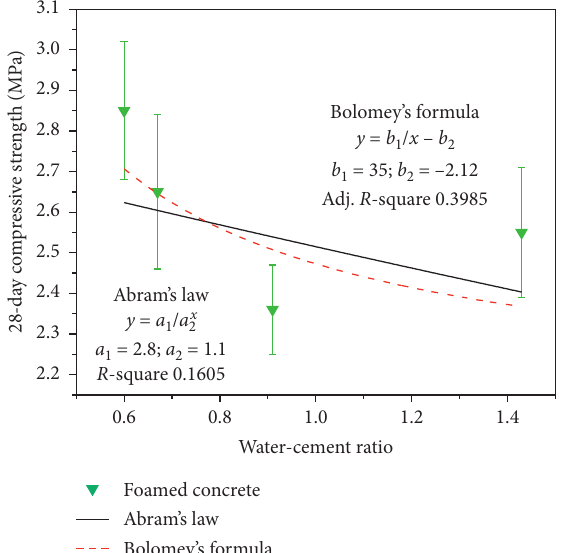
Figure 9: Simulations of Abrams’ law and Bolomey’s formula using water-cement ratio for cement-based materials.